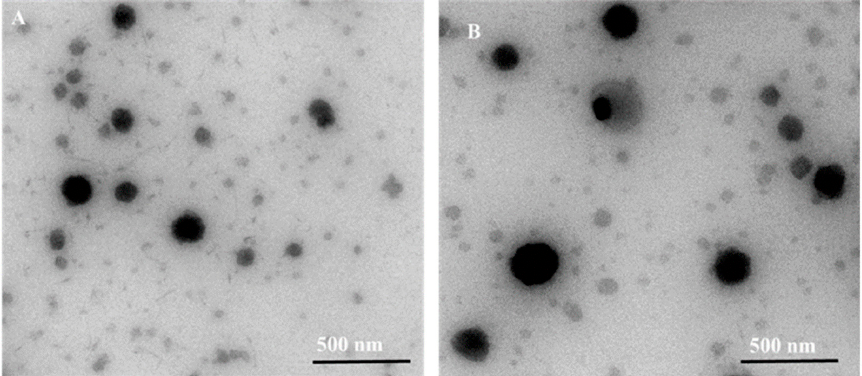
Figure 7. TEM image of ( A ) metoprolol-loaded deformable liposome and ( B ) metoprolol-loaded chitosan coated deformable liposome. Reproduced from Badran et al. [38].